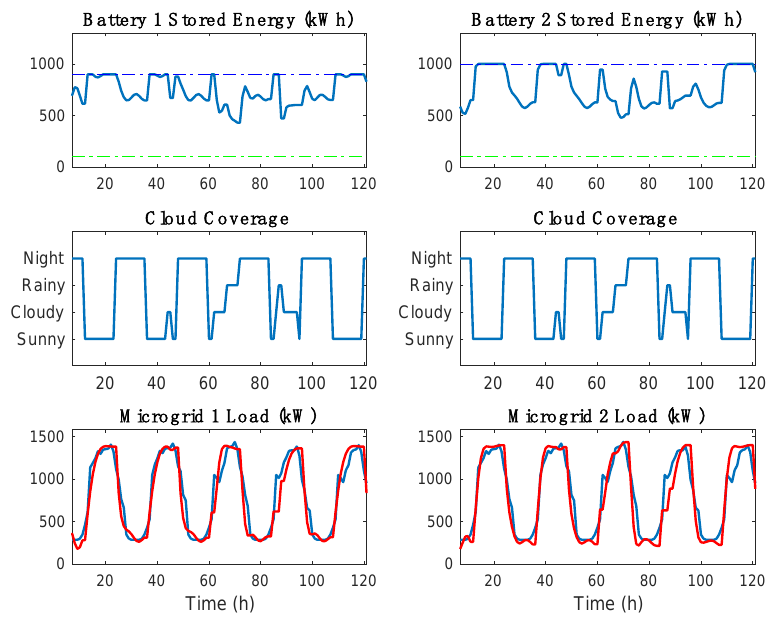
Figure 7. Simulation results when µ Grids 1 and 2 are connected: the battery energy ( top figure), cloud coverage ( middle figure), load (red line) and average commercial load (blue line) ( bottom figure).